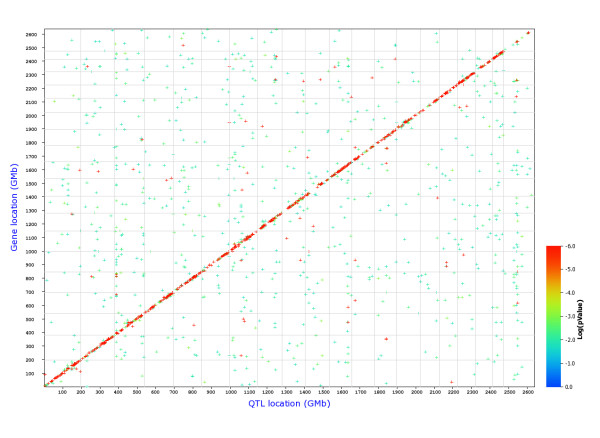
Genome-wide graph of cis- and trans-eQTLs in Treg cells. The positions of the eQTLs are plotted against the locations of the corresponding transcript along the genome. Cis-regulated genes are located along the diagonal, all other dots represent trans-regulated genes. The significance level of each QTL is indicated by the color. FDR = 0.3.